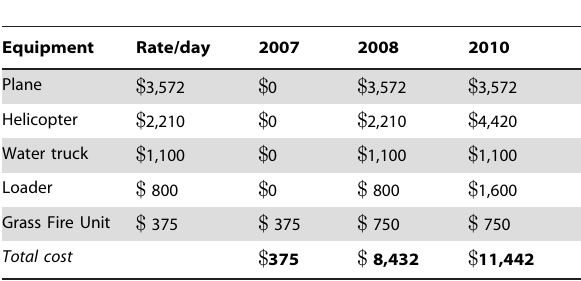
Table 3. Cost of fire management stand-by equipment in 2007, 2008 and 2010.